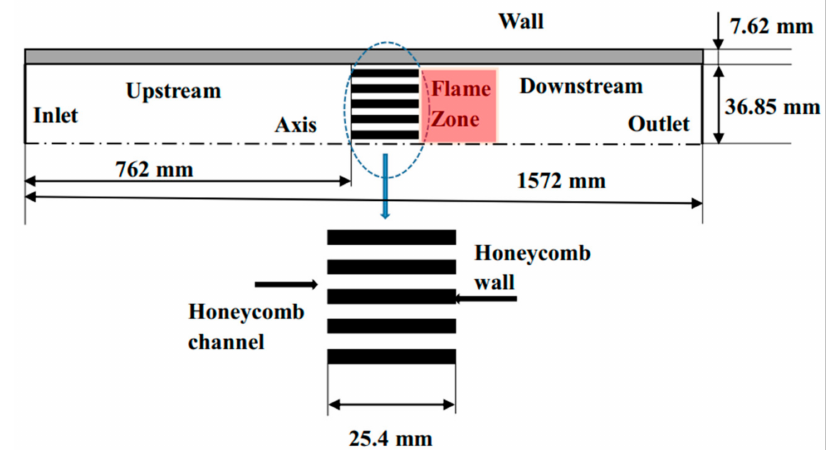
Figure 2. Configuration of the axisymmetric Rijke burner model (not to